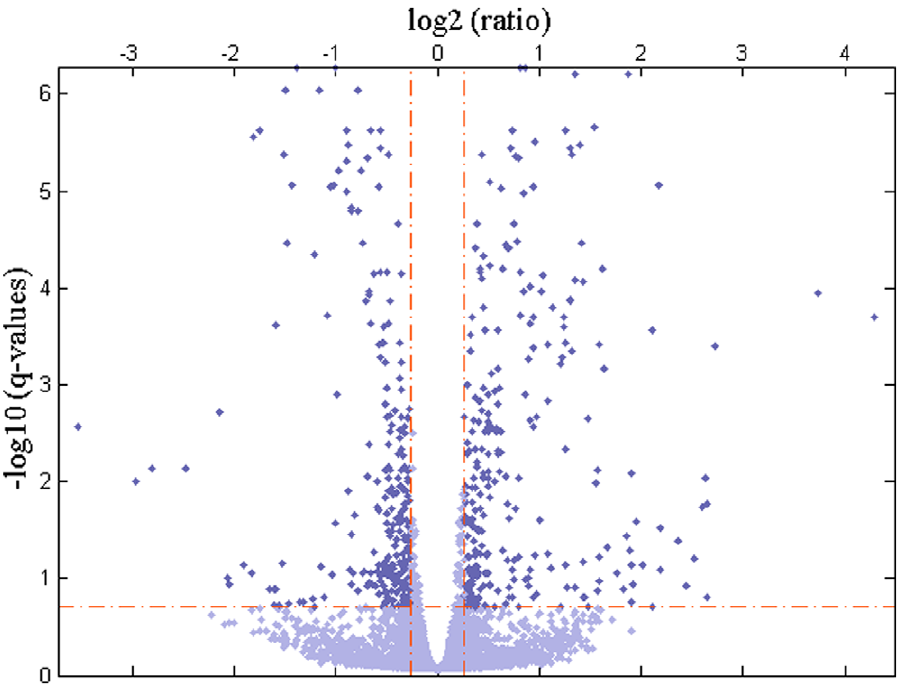
Figure 3. Significant gene detection. A volcano plot that depicts the –log10 of q -values against log2 of fold changes for all genes in GSE1977.